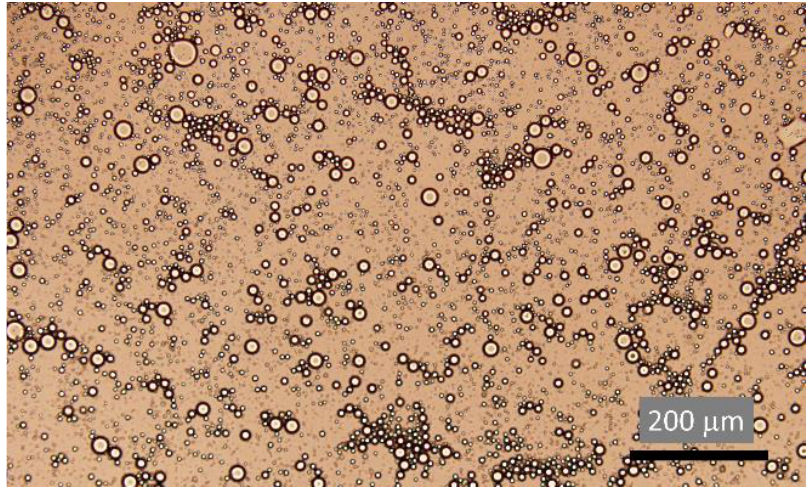
Figure 11. Optical image of oil/water emulsion observed in optical microscope.